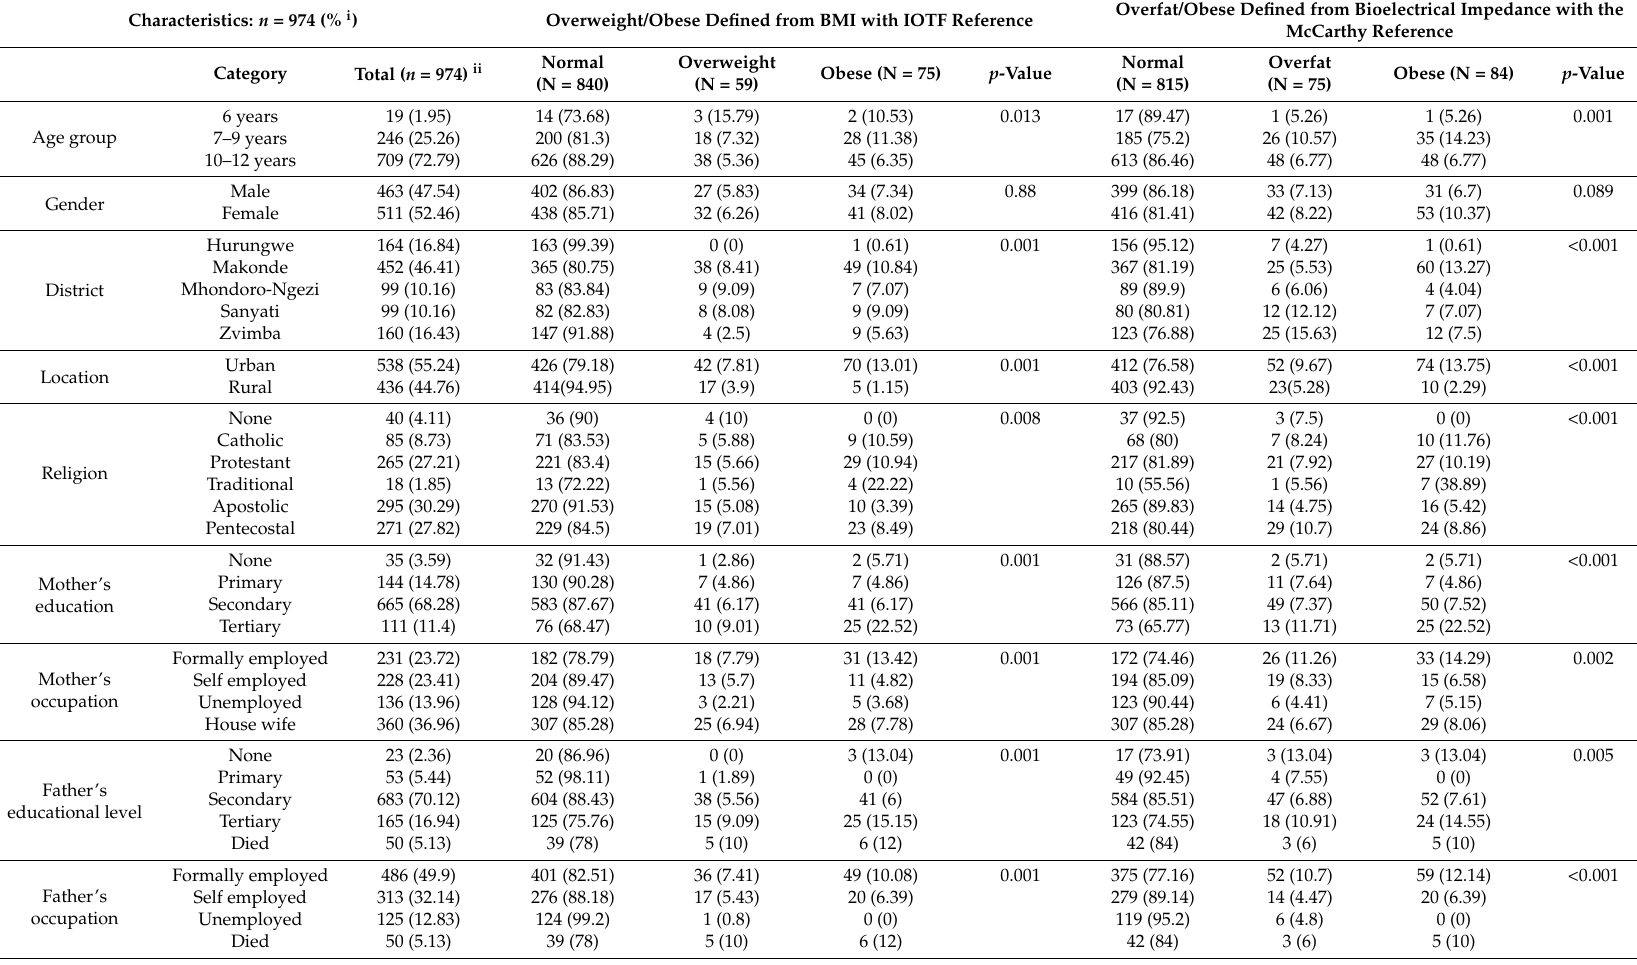
Table 1. Descriptive characteristics of overweight/obese and overfat/obese study of school children, as defined by IOTF (Cole, 2012), BMI-for-age reference, and (McCarthy, 2006) body fat reference